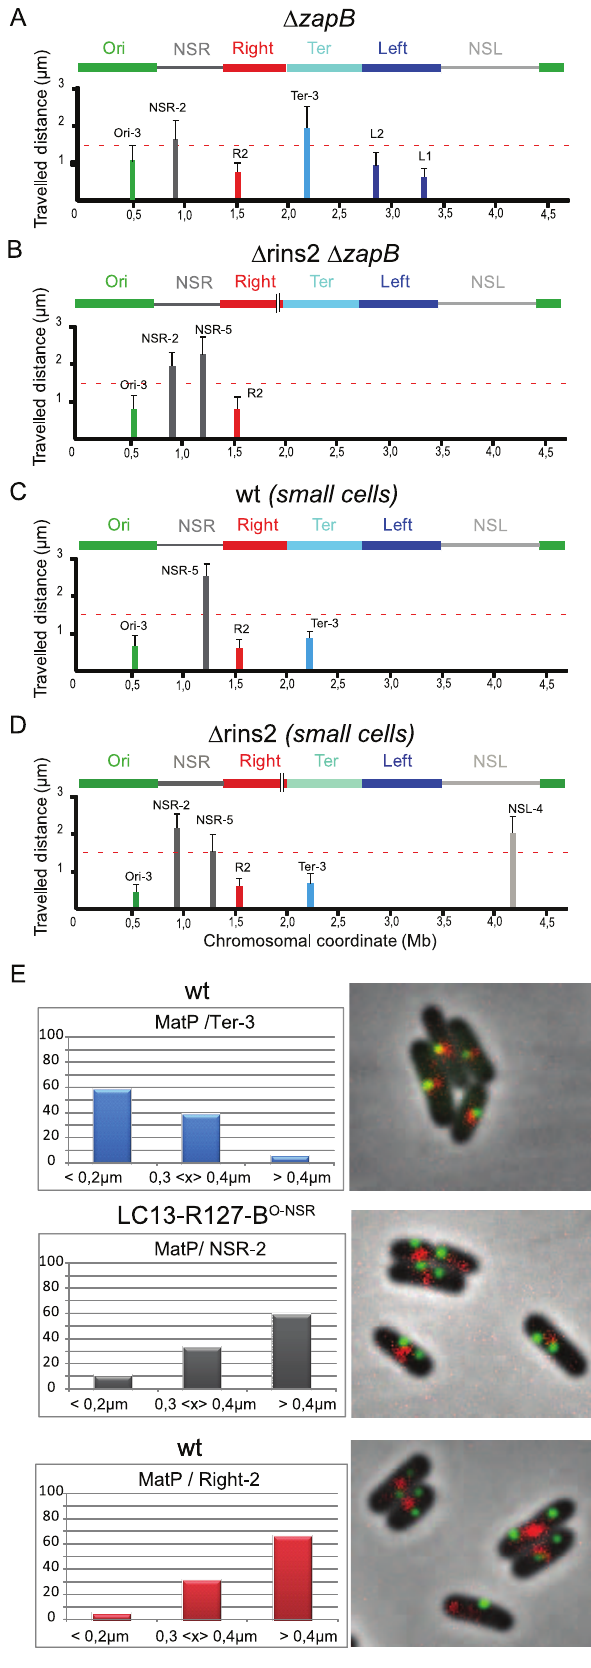
Figure 6. The constraining process depends on MatP and ZapB. (A–D) Travelled distance of different markers in strains deleted for zapB , deleted for segment rins2 and zapB , and in wt strain. The representation is the same as in Figure 2. (A) strain with a deletion of zapB (markers Ori- 3, NSR-2, Right-2 (R2), Ter-3, Left-2 (L2), Left-1 (L1) are indicated from left to right). (B) strain with a deletion of zapB and rins2 (markers Ori-3, NSR-2, NSR-5, Right-2 (R2) are indicated from left to right). (C) small cells of wt strain before Ter MD segregation at mid-cell (markers Ori-3, NSR-5, Right-2 (R2), Ter-3 are indicated from left to right). (D) small cells of strain D rins2 before Ter MD segregation at mid-cell (markers Ori-3, NSR- 2, NSR-5, Right-2 (R2), Ter-3, NSL-4 are indicated from left to right). (E) Quantification of the co-localisation of the MatP-mCherry focus (red) with a chromosomal parS tag bound by ParB-GFP (green). The percentage of cells presenting different interfocal distances is given (left column). In the top lane, the MatP-mCherry focus co-localizes with the Ter-3 marker in the wt strain. The interfocal distance is smaller than 0.4 m m in more than 90% of the cells. In the central lane, the MatP- mCherry focus does not co-localize with the NSR-2 marker in the strain LC13-R127-B O-NSR with a transposition of the Right MD between the Ori MD and the NS Right region (see chromosome configuration in Figure 2). The interfocal distance is greater than 0.3 m m in almost 90% of the cells. In bottom lane, the MatP-mCherry focus does not co-localize with the Right-2 marker in the wt strain. The interfocal distance is greater than 0.3 m m in 90% of the cells.